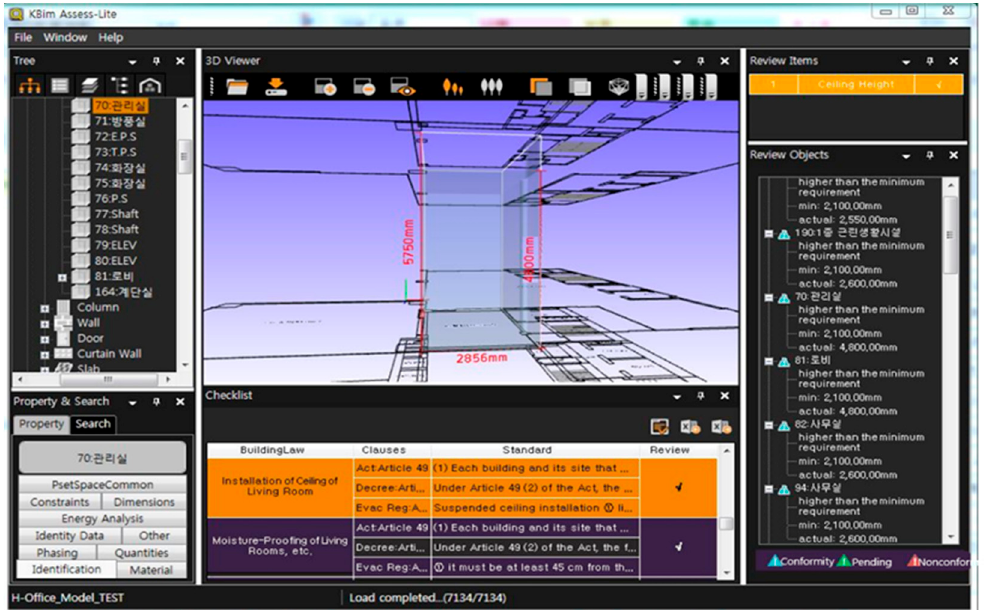
Figure 9. Example of rule-based quality checking results according to design check criteria (e.g., installation of ceiling).